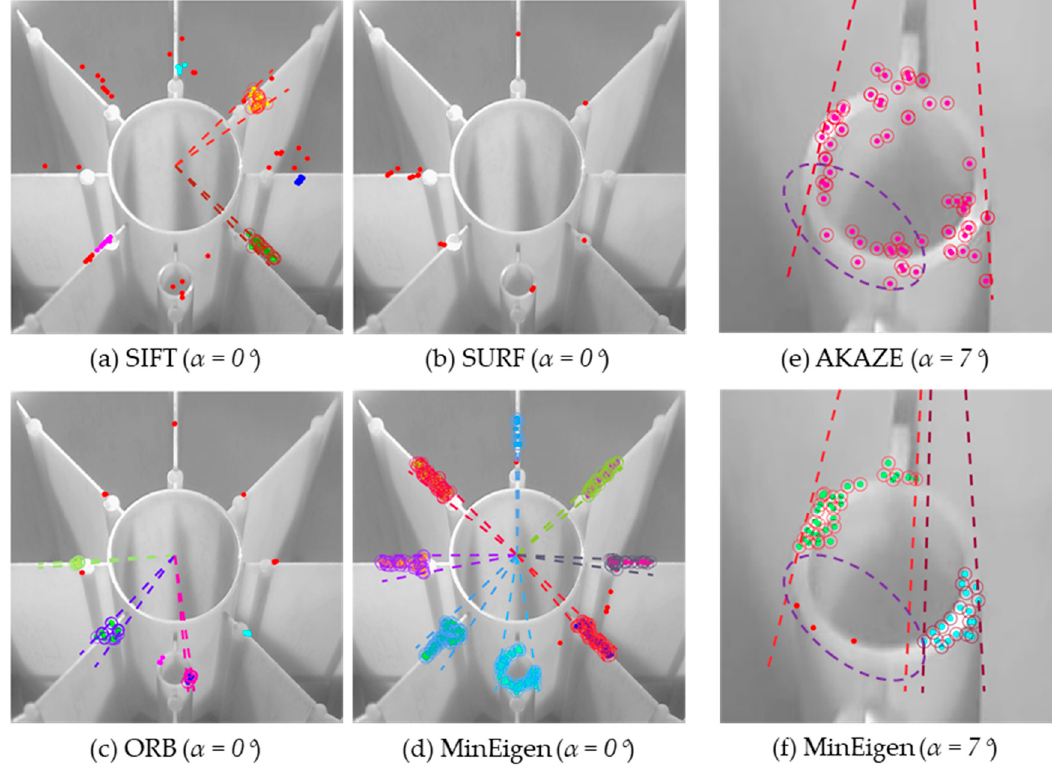
Figure 10. FPDD results of ( a ) SIFT, ( b ) SURF, ( c ) ORB and ( d ) MinEigen ( α = 0°), and comparison of feature point distribution near drive bore for ( e ) AKAZE and ( f ) MinEigen ( α = 7°).